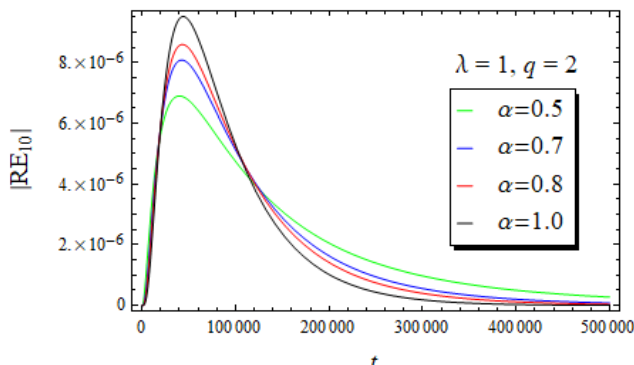
Figure 4. Effect of the conformable derivative order α on the residual at λ = 1, q = 2.